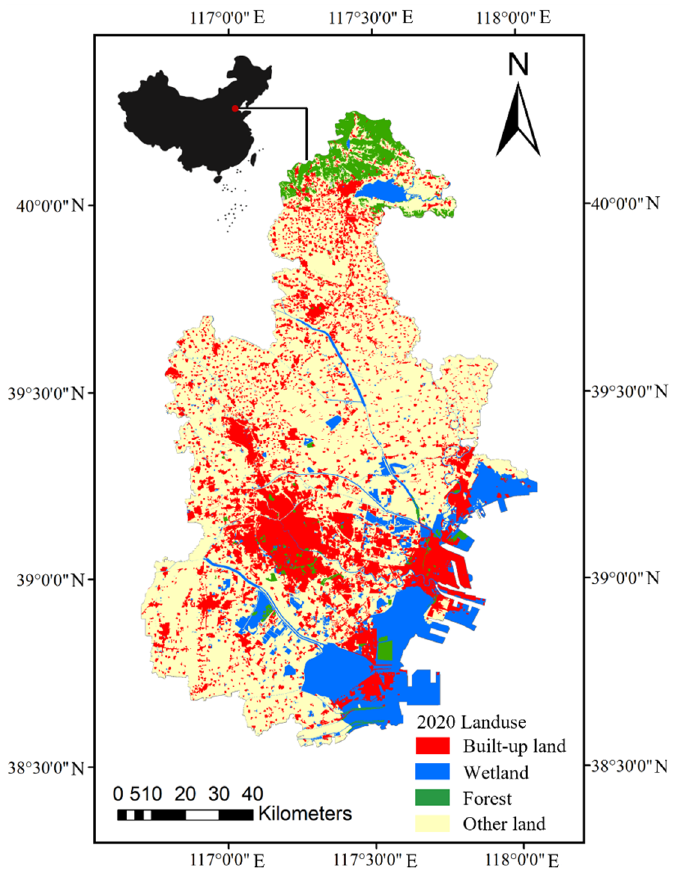
Figure 2. Location of Tianjin, China.